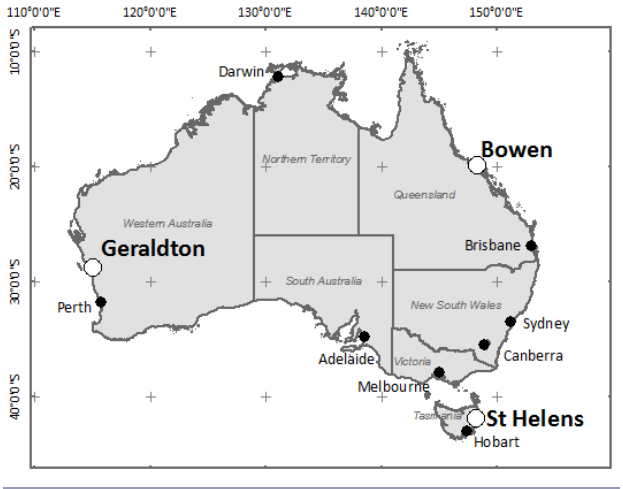
Fig. 1 . Map of Australia showing the location of the three case study coastal communities: Geraldton, Western Australia; St Helens, Tasmania; and Bowen,